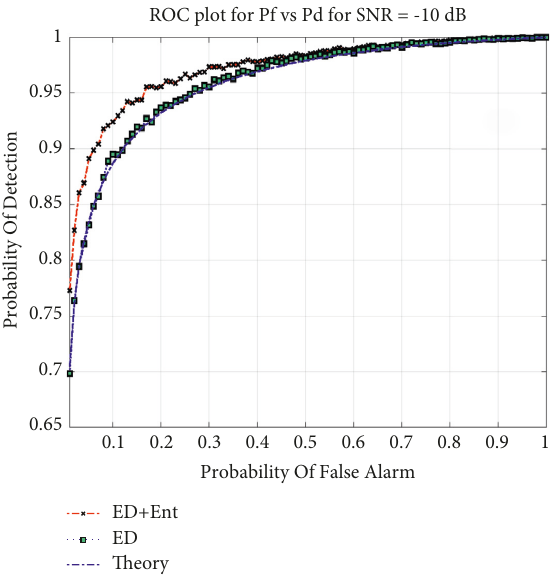
Figure 7: P f vs. P d at SNR